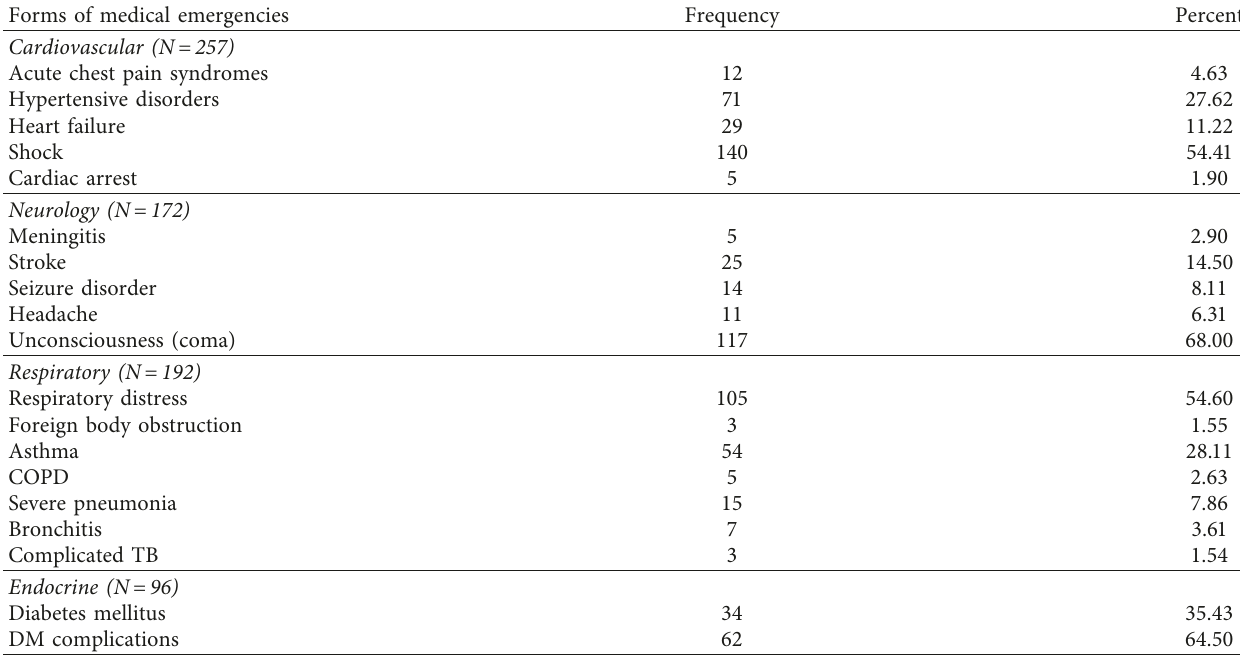
Table 4: Identified medical emergencies as leading causes of emergency room admission, Nekemte, Ethiopia, 2017. Forms of medical emergencies